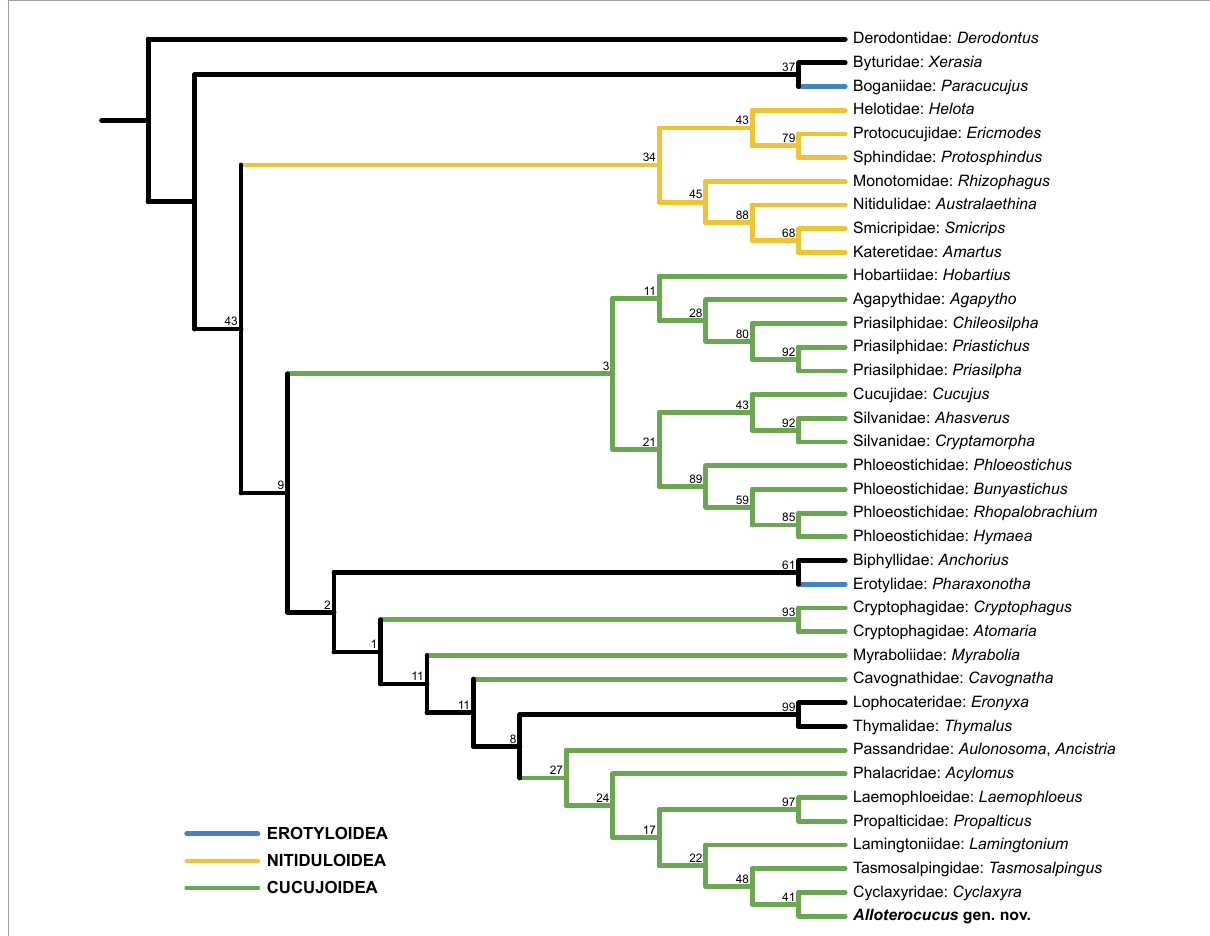
FIGURE5 Placement of Alloterocucus Li, Leschen Liu, and Cai gen. nov. based on the single tree resulting from the unconstrained parsimony analysis.